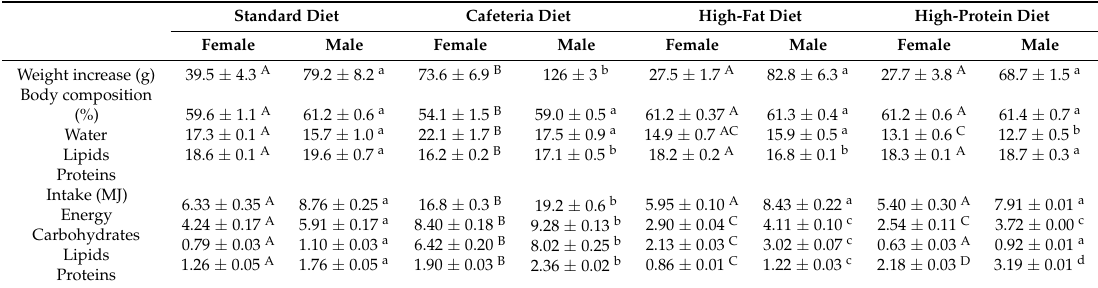
Table 2. Body weight increase and composition, energy, and macronutrients intake. Standard Diet Cafeteria Diet High-Fat Diet High-Protein Diet Female Male Female Male Female Male Female Male